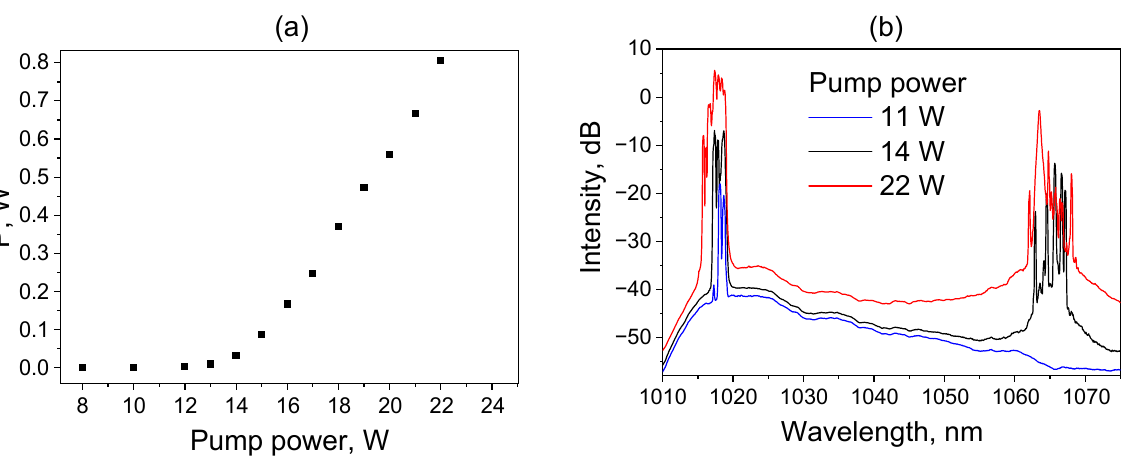
Figure 3. Output average power of RFL as a function of coupled to fiber input pump power ( a ) and output spectrum at different LD pump powers in 62.5- µ m GRIN fiber Raman laser with the open-space AOM ( b ).